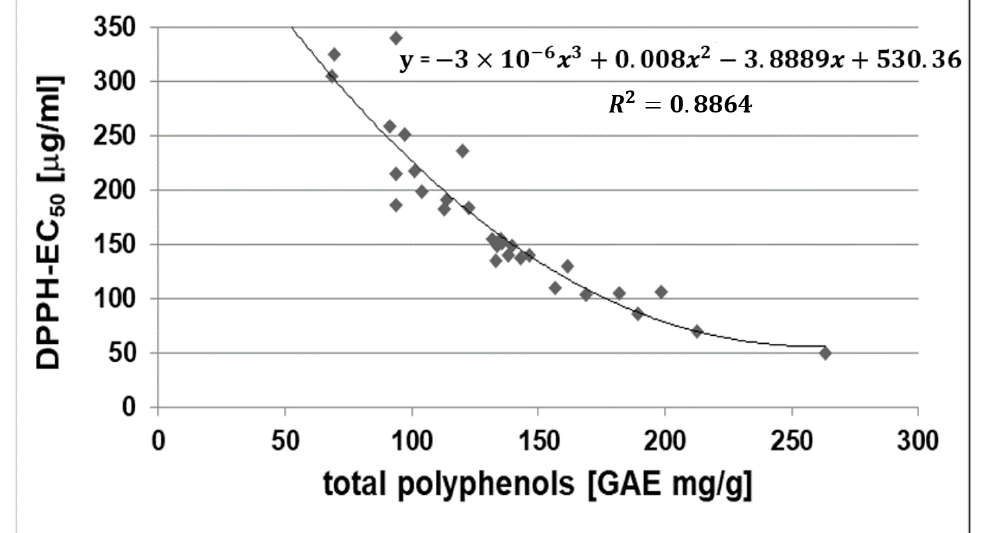
Figure 1. Correlation of the total polyphenol content with the DPPH-radical scavenging half-maximum concentrations (DPPH-EC 50 ) of the studied juniper extracts. Lower EC 50 values denote higher